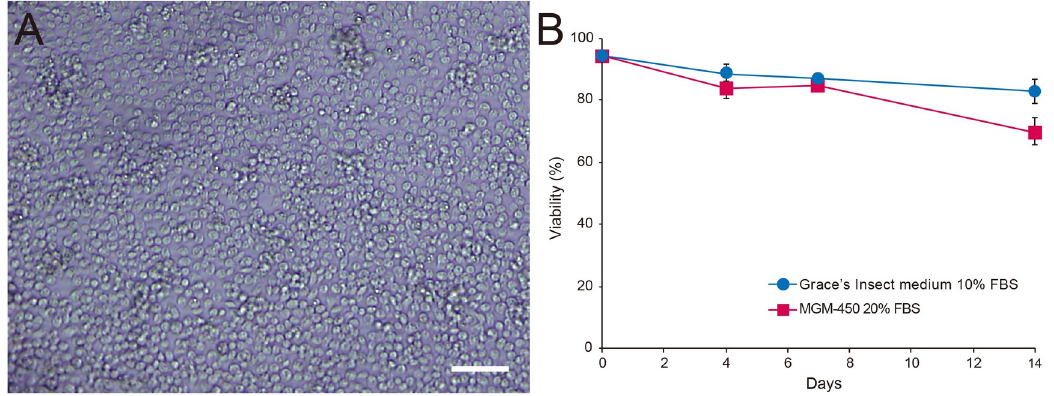
Fig 4. Ex vivo cultured hemocyte cells and viability after incubation. A . Hemocyte cells obtained from the hemolymph of 15 larval equivalents were fully confluent (approximately 4.45 x 10 5 cells/well) in a well of a 96-well plate. The bar indicates 100 μ m. B . Viability of cells after the incubation. Viability is the ratio of viable cells among all cells counted using a hemocytometer (three replications for each incubation period). Error bars indicate the standard error of the mean.